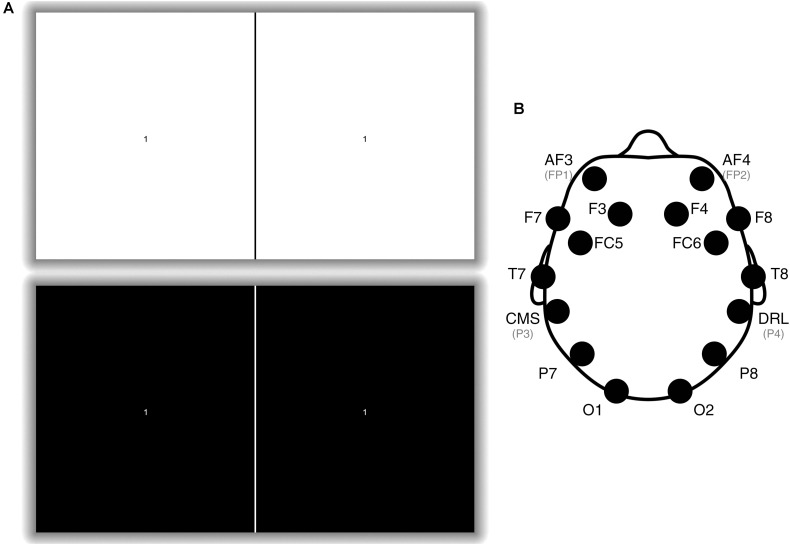
(A) An example of the visual stimulus. The stimulus alternated between the top and bottom picture at a rate of 15 times per second. There is a fiducial line in the middle used to align the screen with the Google Cardboard headset. The number at the center of each square changed at 5 s intervals and participants were instructed to focus on the number for a total of 30 s. NB, The shadow does not exist on the actual stimulus but is utilized here to make the visual stimulus clearer to view. (B) Emotiv EPOC+ electrode positions (Liu et al., 2012). Only electrodes P3 (CMS), P4 (DRL), O1, and O2 were utilized: P3 and P4 were utilized as a common-mode subtraction/driven-right-leg reference and ground, and O1 and O2 were the analyzed electrodes.